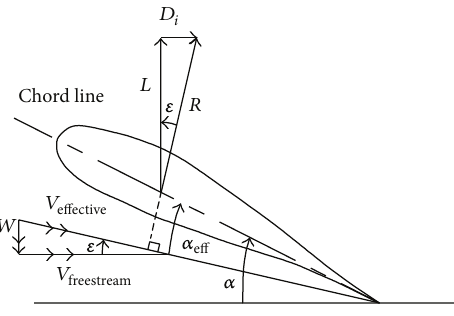
Figure 1: Lift and drag of a wing section